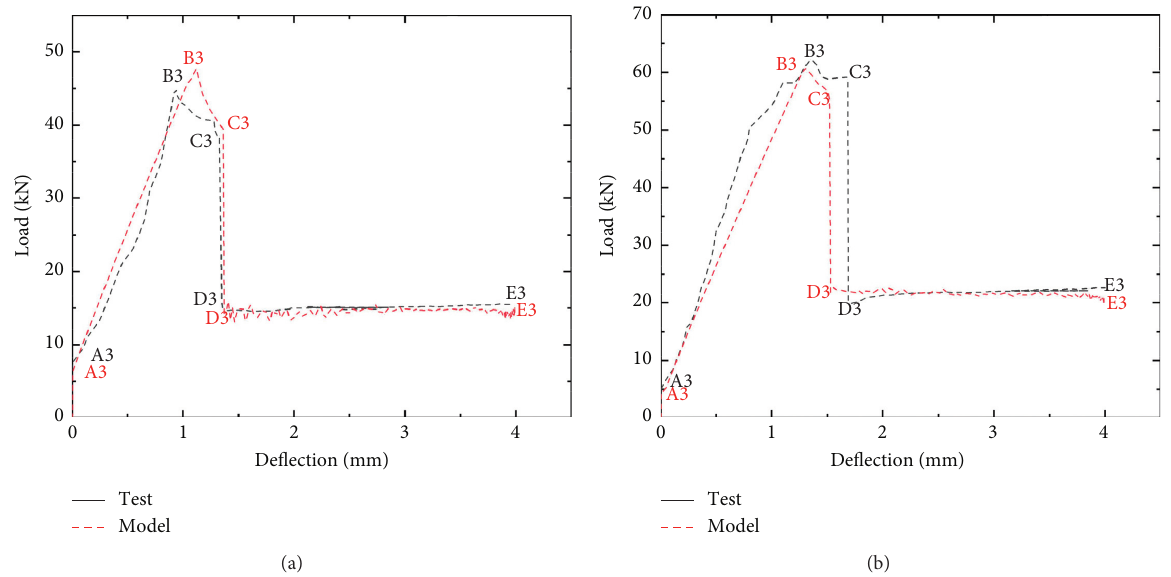
4.44 . (b) CD-ERA-P- λ 3.33 .